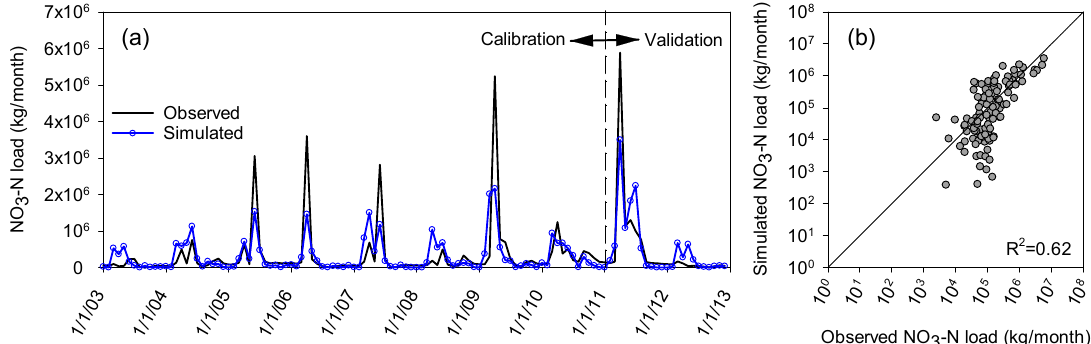
Figure 7. ( a ) Comparison of the simulated and observed chemographs and ( b ) graphical comparison of the observed and simulated NO 3 -N loads for CS2 at the Grand Forks gauging station.